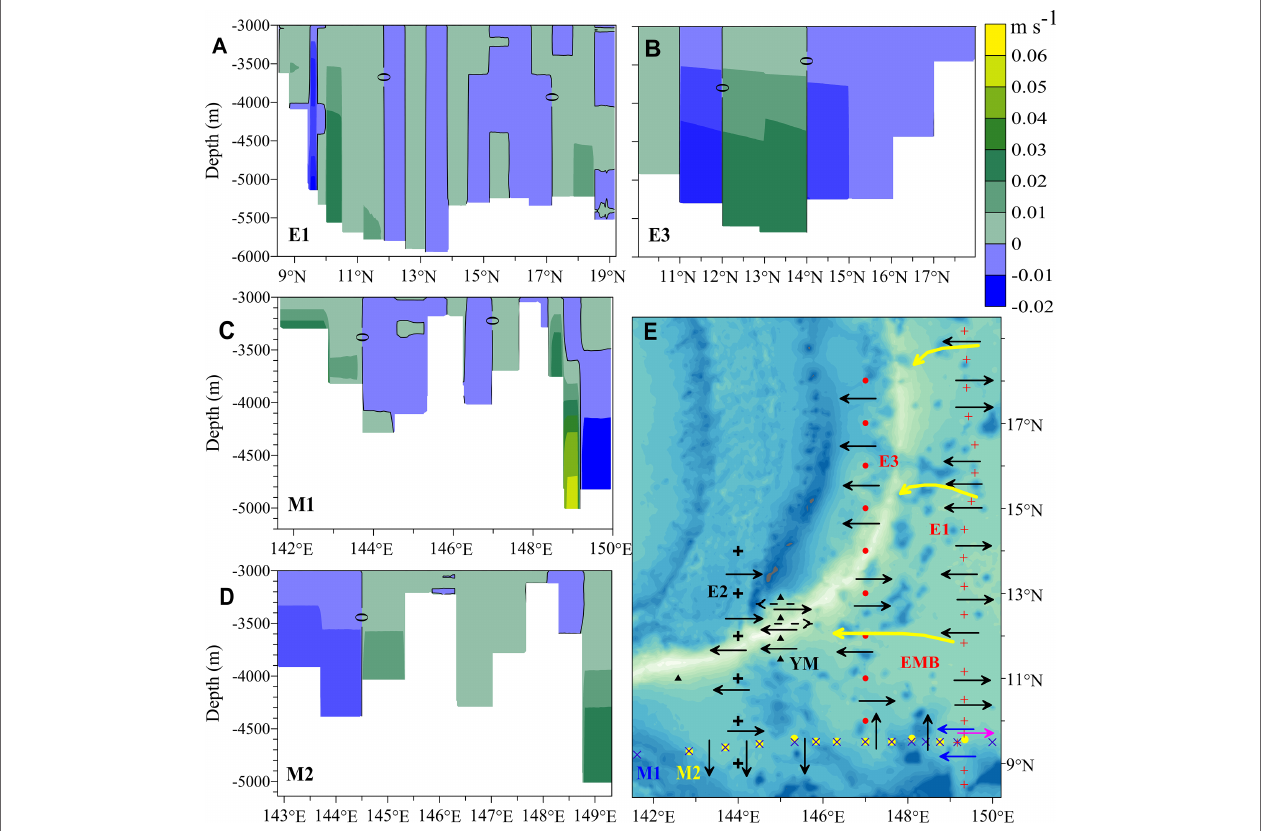
FIGURE 8 | Zonal flows at sections E1 (A) and E3 (B) in the East Mariana Basin, meridional flows at sections M1 (C) and M2 (D) in the East Mariana Basin, and flow patterns (E)